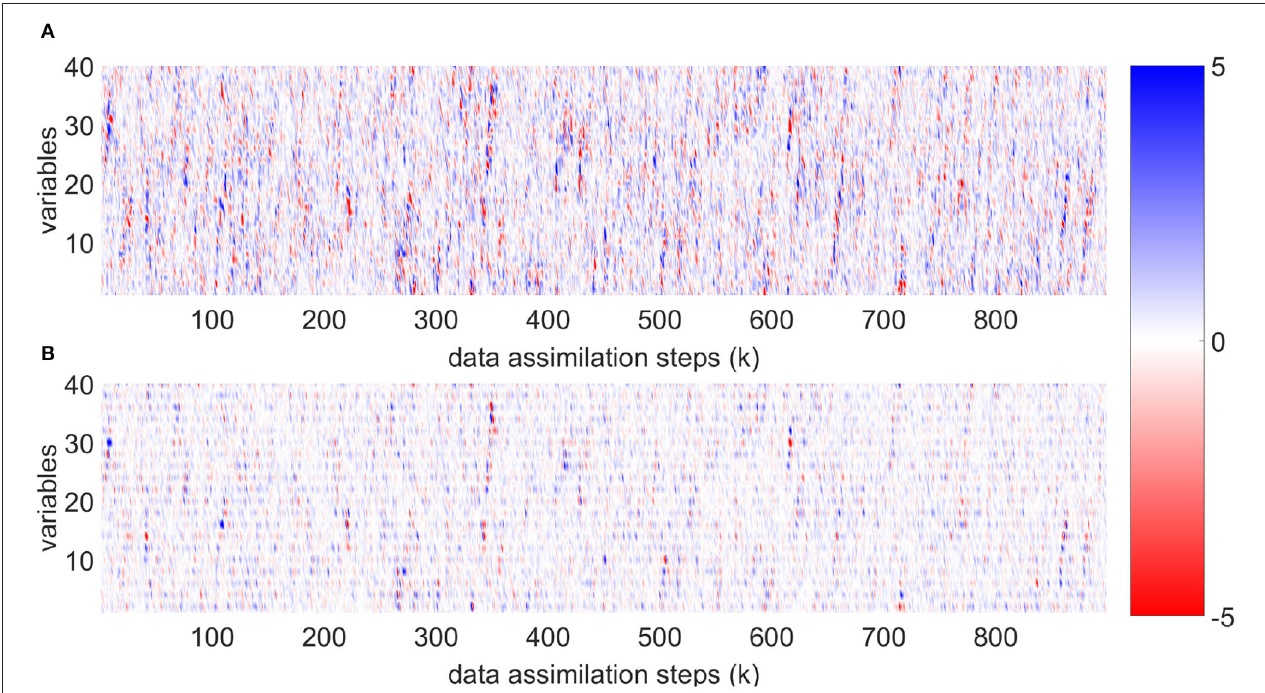
FIGURE 12 | (A) shows the difference of background mean and truth for the LMCPF method for all 40 variables for the experiment described in Figure 11 . In (B) , the analysis mean minus truth is illustrated for the LMCPF method.